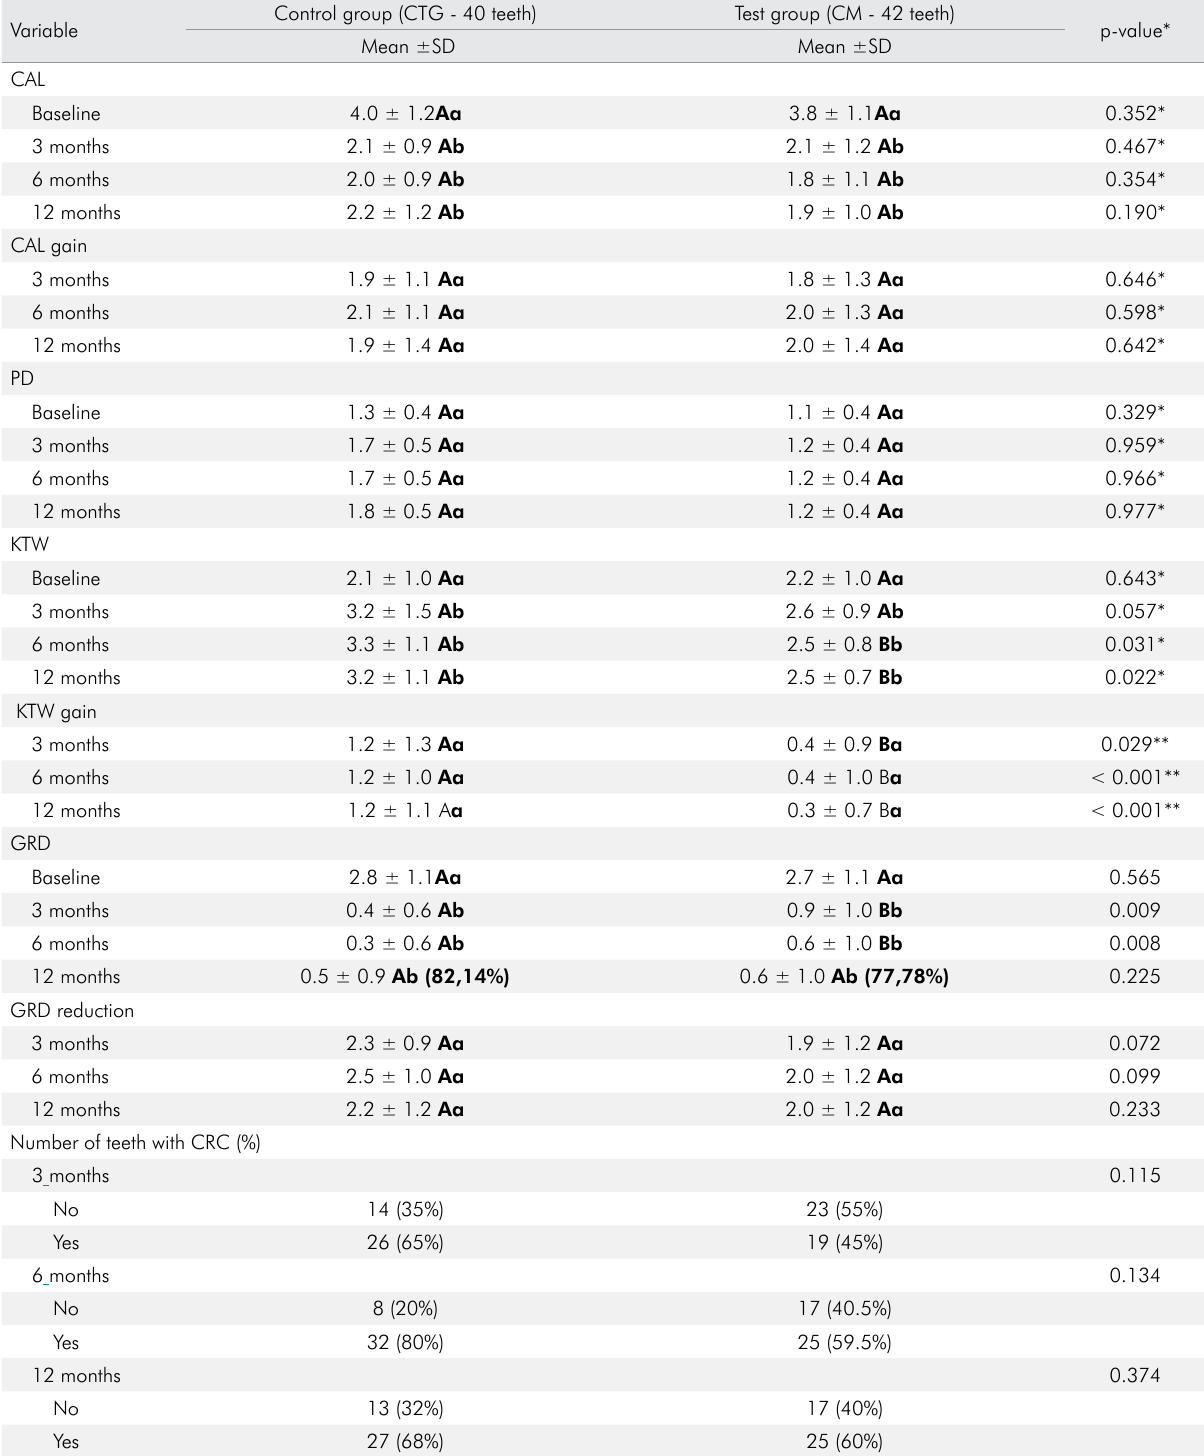
Table 2. Descriptive analysis of the primary clinical outcome (GRD), reduction in GRD, percentage and number of teeth with CRC, and secondary variables 3, 6, and 12 months after